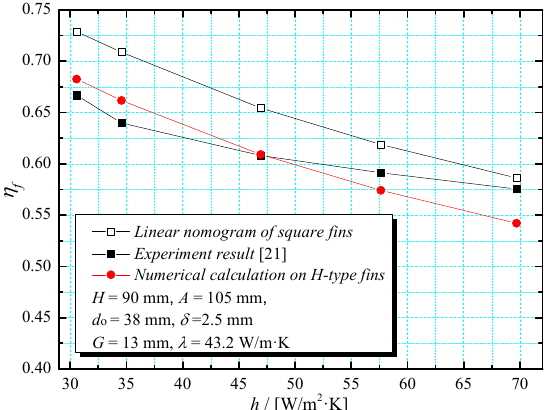
Figure 3. Comparison of fin efficiency η f for method validation.